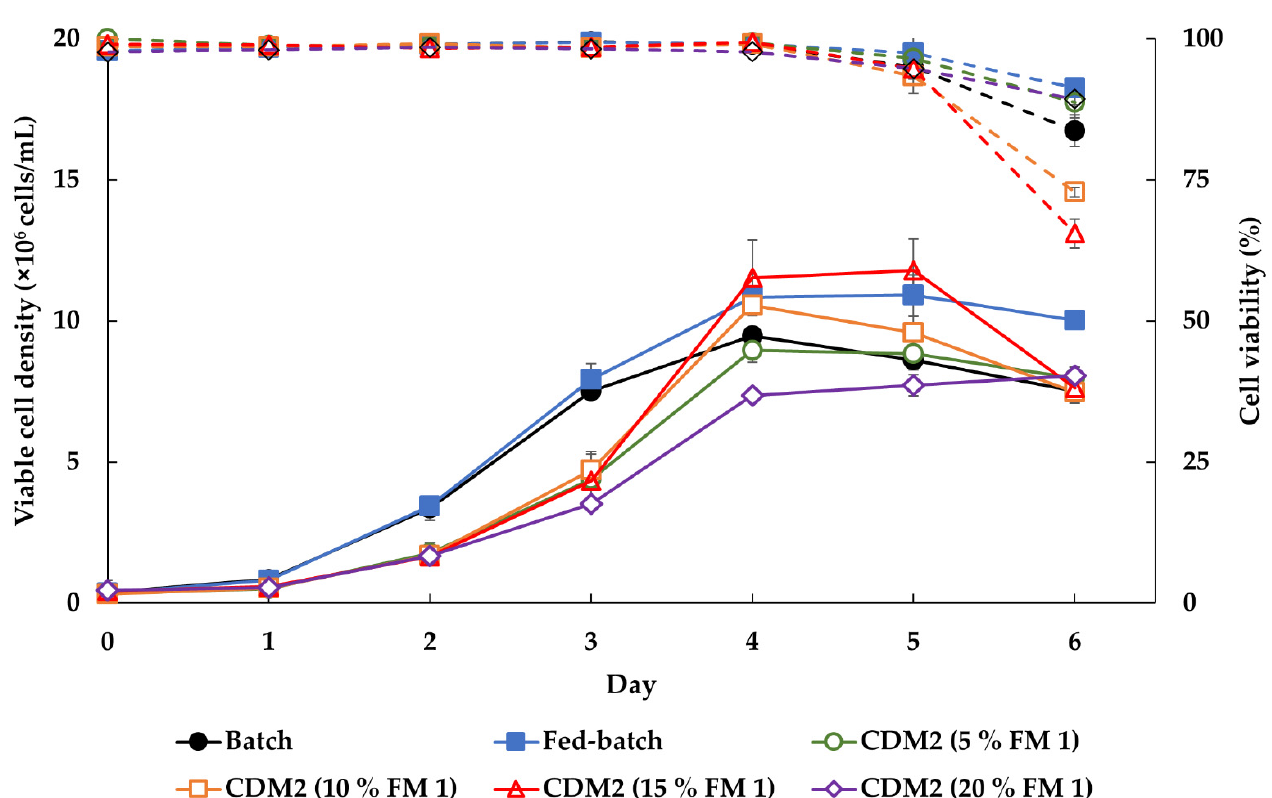
Figure 5. Various culture modes were tested to increase cell density of BHK-S cells and to simplify the culture process. BHK-S cell growth was compared between batch culture ( • ), fed-batch culture ( (cid:4) ), and enhanced batches grown in CDM-2 supplemented with 5 ( ), 10 ( (cid:3) ), 15 ( (cid:52) ), and 20 ( )% home-made FM- 1 (25 g/L, pH 7.4). On days 0 and 2, the media used for the fed-batch cultures were supplemented with 5% v/v FM-1. Solid line is viable cell density and dash line is cell viability. Each experiment was carried out in triplicate. Data expressed as mean ± standard deviation.